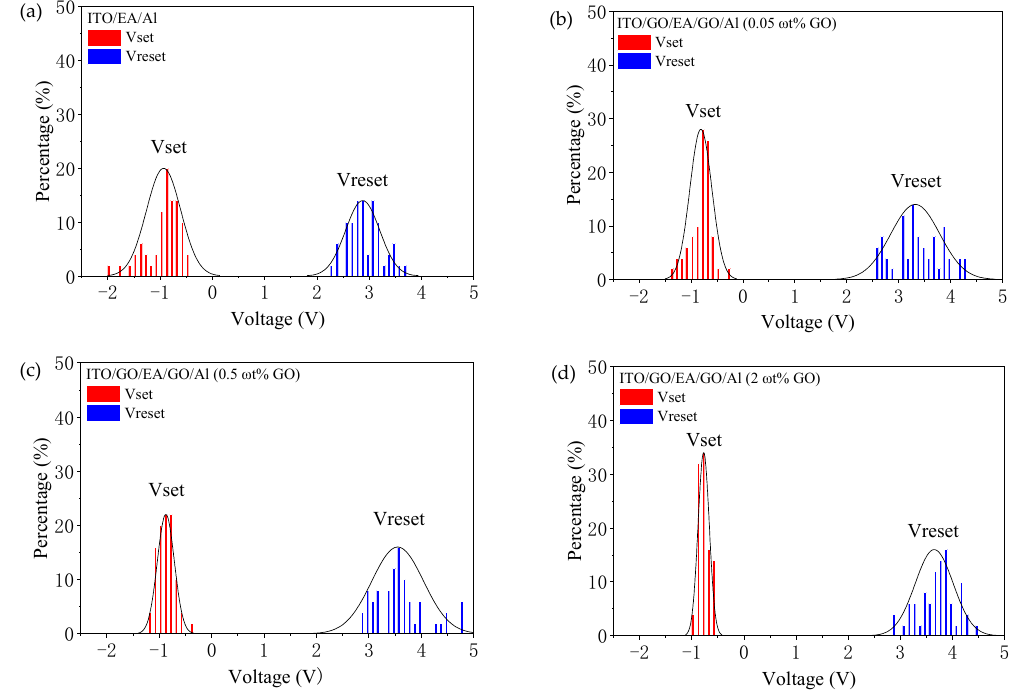
Figure 12. Vset and Vreset distributions of the devices: ( a ) ITO/EA/Al device. ( b – d ) ITO/GO/EA/GO/Al devices with GO concentrations of ( b ) 0.05 ω t%, ( c ) 0.5 ω t%, and ( d ) 2 ω t%.